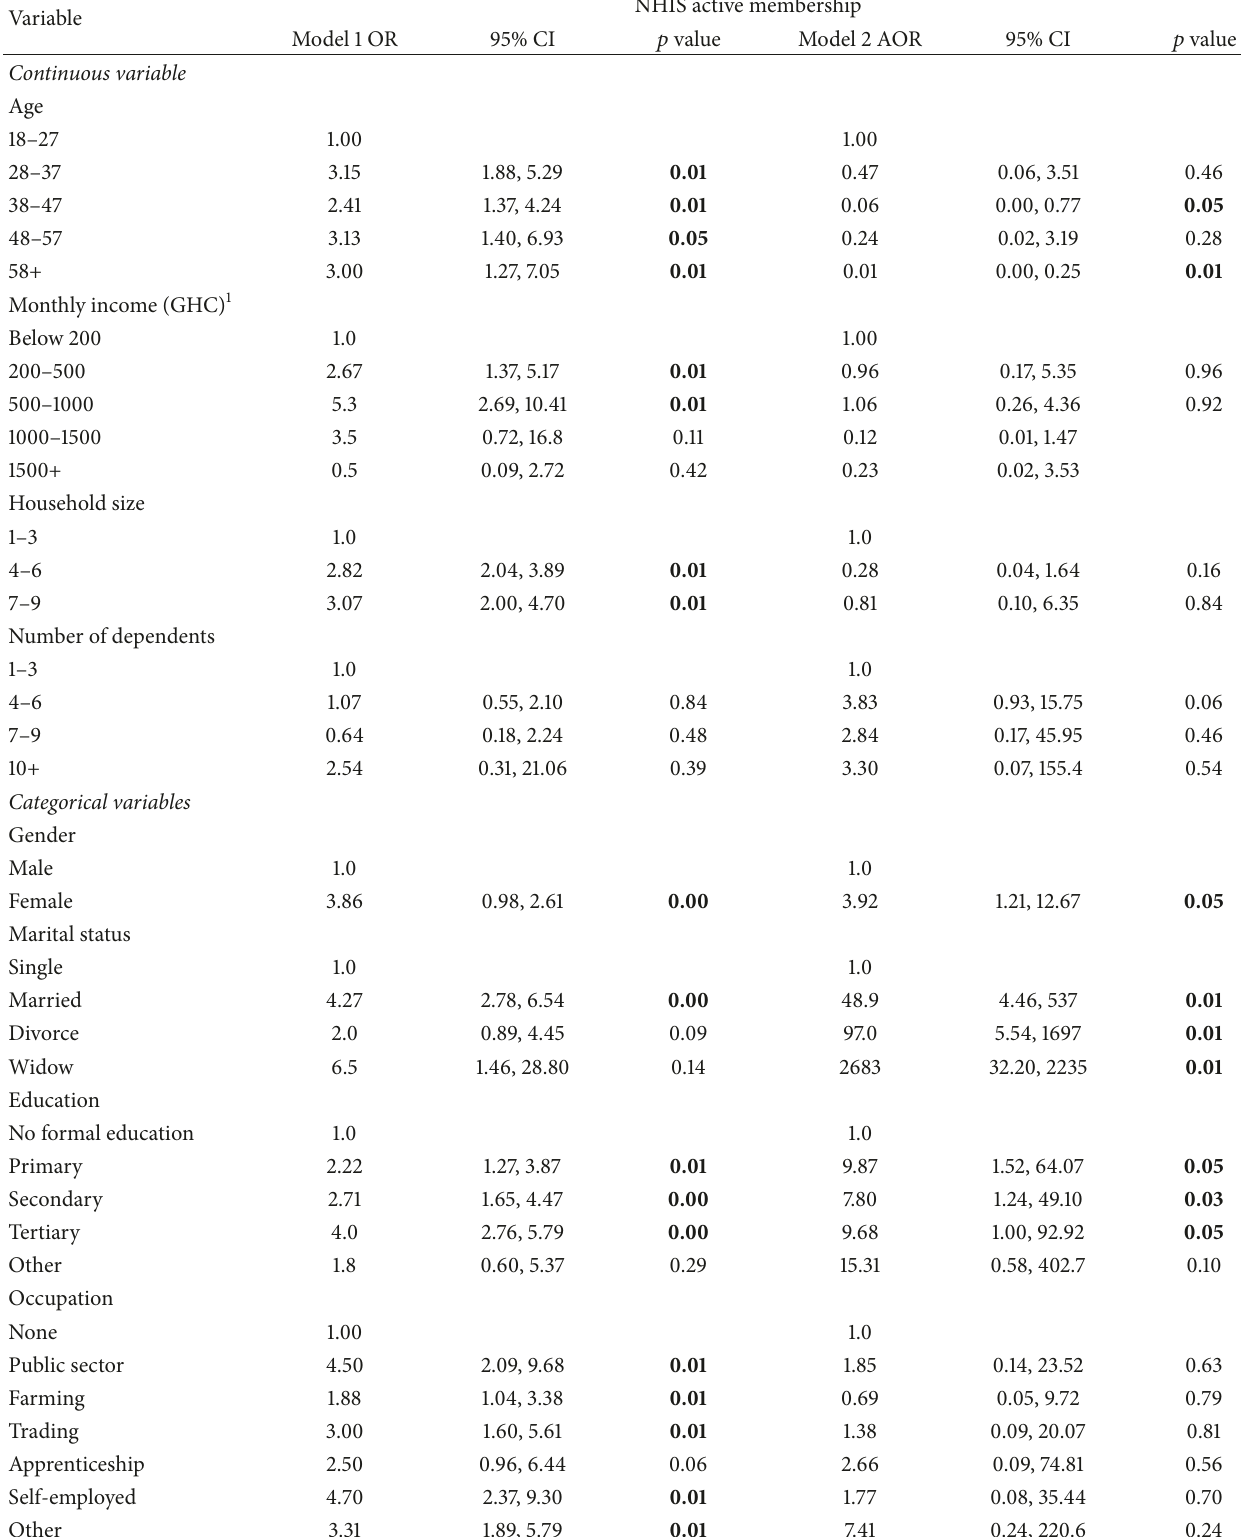
Table 2: Logistic regression analysis of households’ profile and NHIS